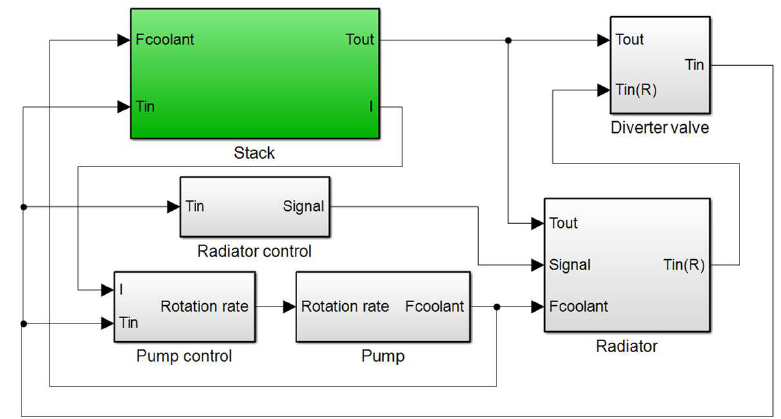
Figure 2. Simulink simulation model of cooling system.